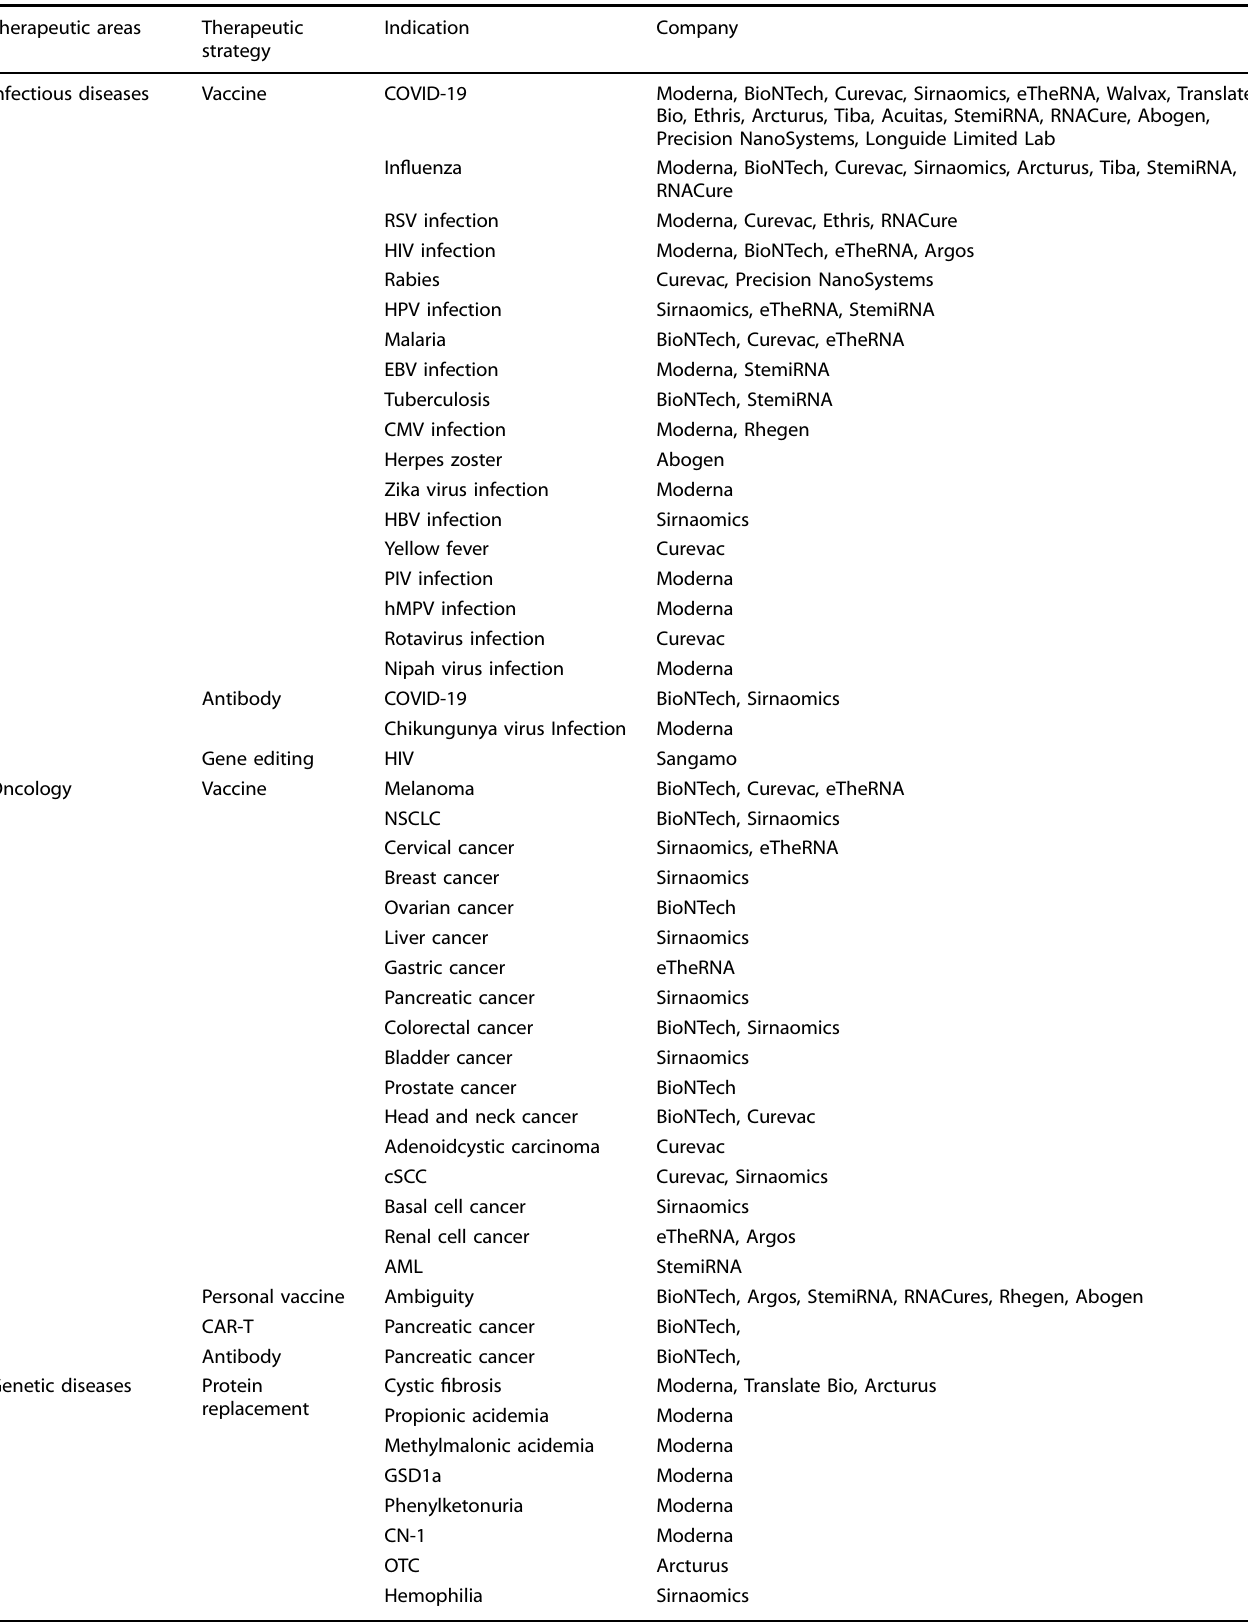
Table 2. Current status in mRNA therapeutics